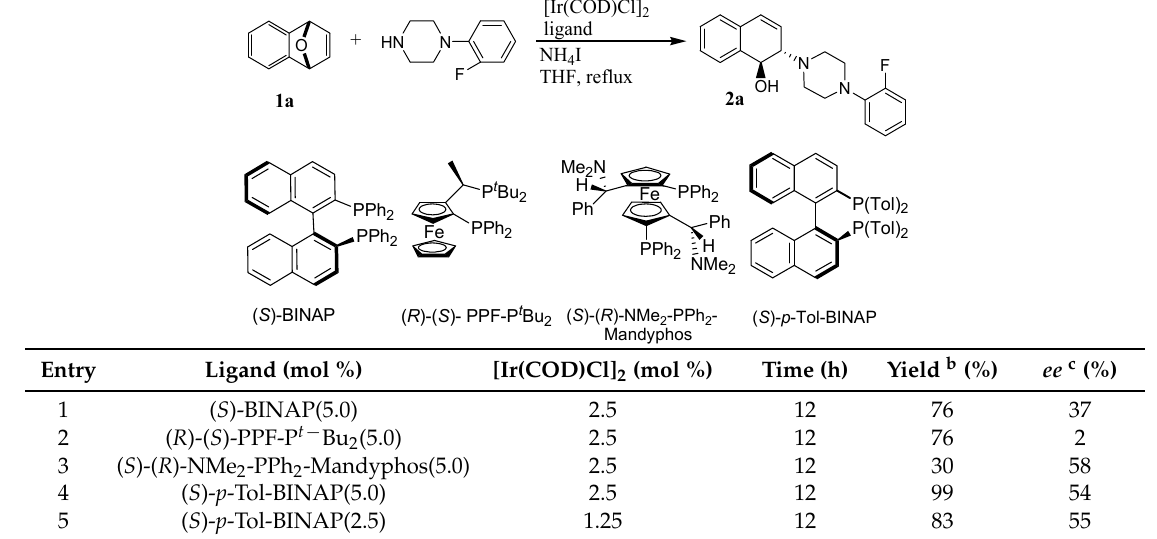
Table 1. Effects of chiral bisphosphine ligands and catalyst loading a .